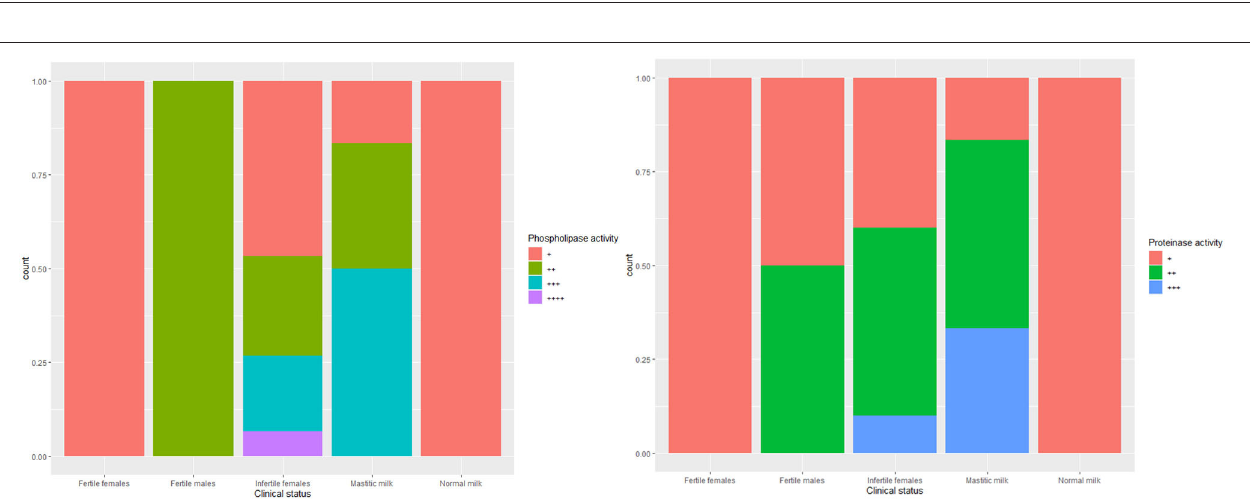
FIGURE 8 | The strength of phospholipase and proteinase activities of C. albicans isolates from milk and genital tract of dromedary camel.